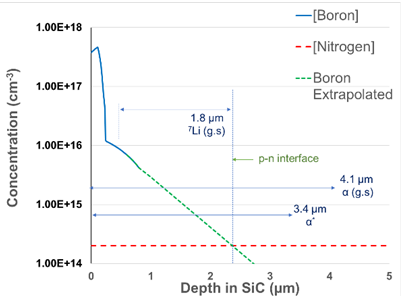
Fig. 5. Boron concentration distribution in SiC assuming a reduction of all boron concentrations by a factor of 120 from those used in the as-built detector